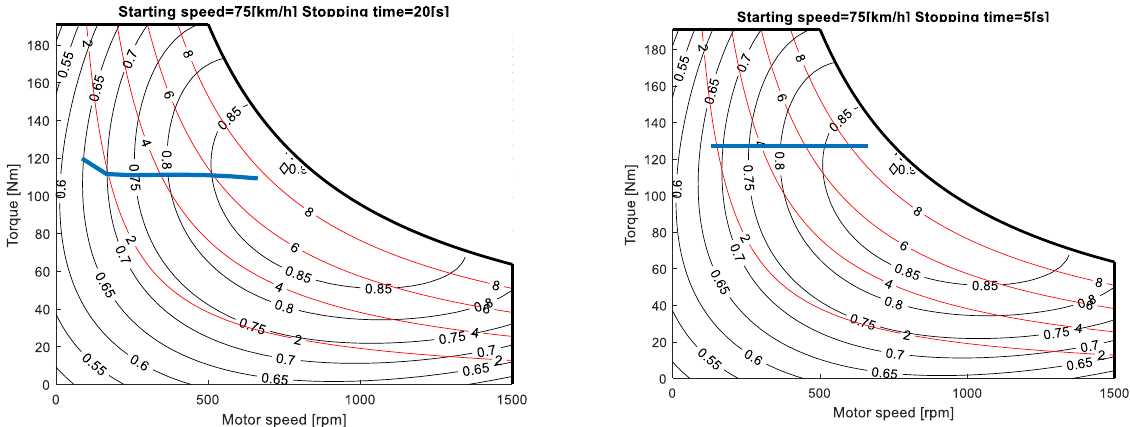
Figure 13. Speed/torque trajectory on the electric generator map during braking forces at the best conditions ( Left ) and at the lowest stopping time ( Right ), starting at 75 km/h.